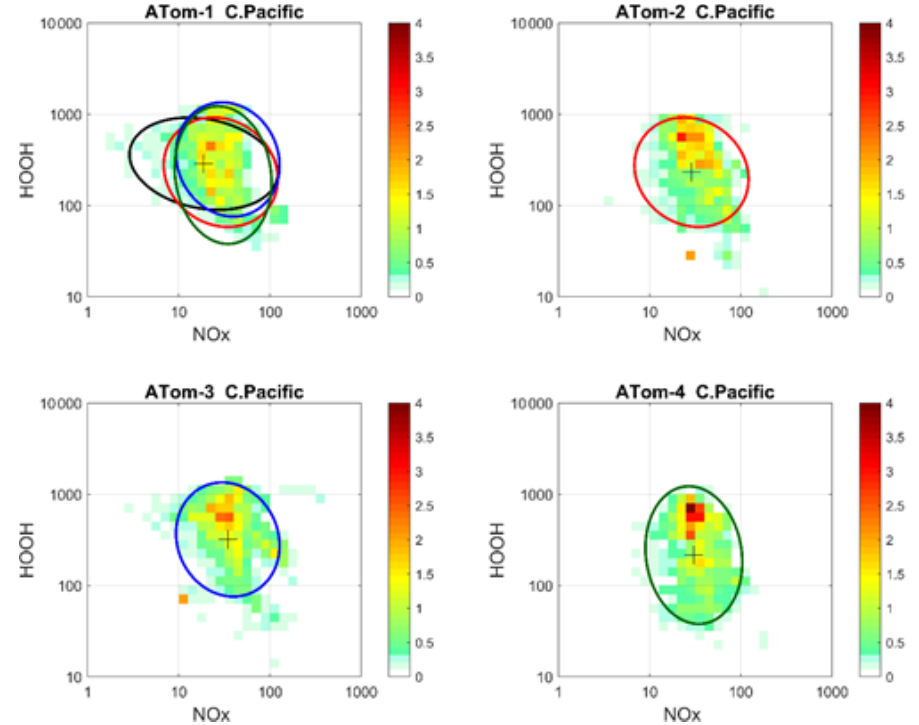
Figure 7. 2D frequency of occurrence (PDs in log ppt mole fraction) of HOOH vs. NO x for the tropical central Pacific for all four ATom deployments. The cross marks the mean (in log space), and the ellipse is fitted to the rotated PD having the smallest semi-minor axis. The semi-minor and semi-major axes are 2 standard deviations of PD in that direction. The ellipses from ATom-2 (red), ATom-3 (blue) and ATom-4 (dark green) are also plotted in the ATom-1